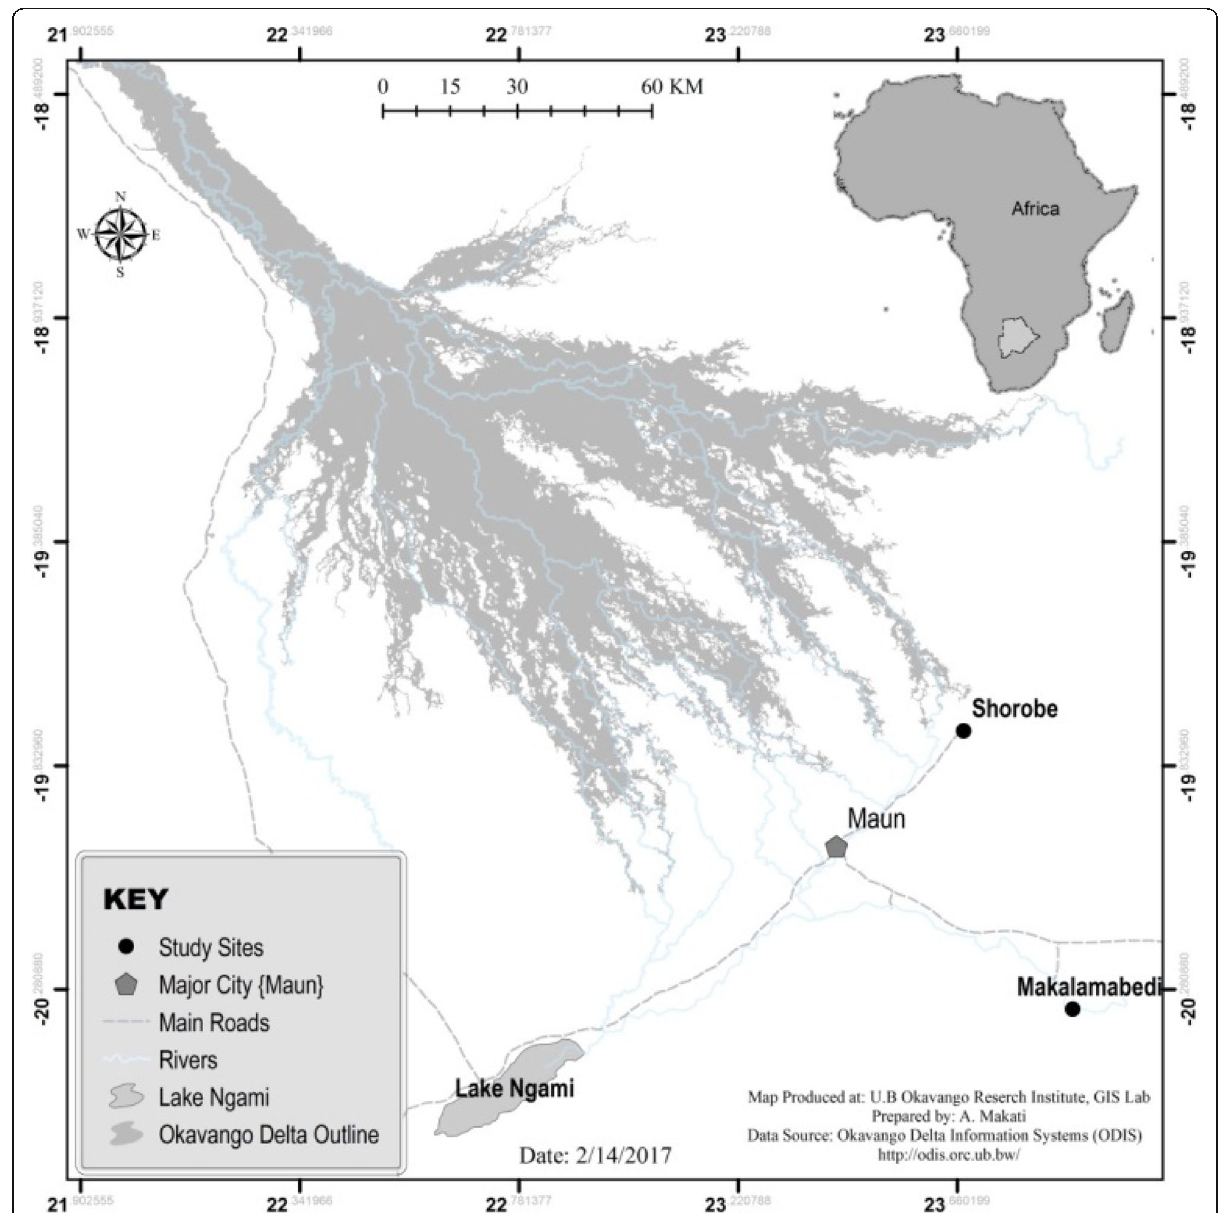
Fig. 1 The Okavango Delta area, showing the study sites of Shorobe, Makalamabedi and Lake